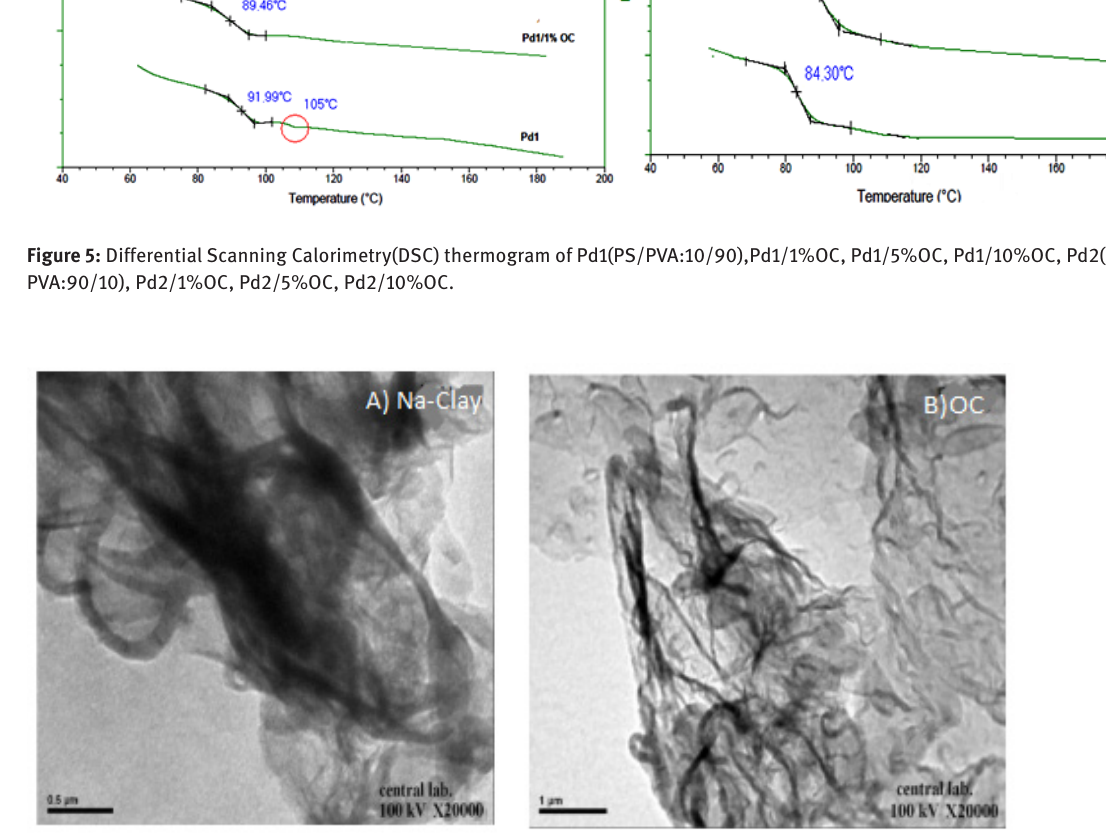
Figure 6: Transmission Electron Microscope(TEM) images of A)Na-clay and B)